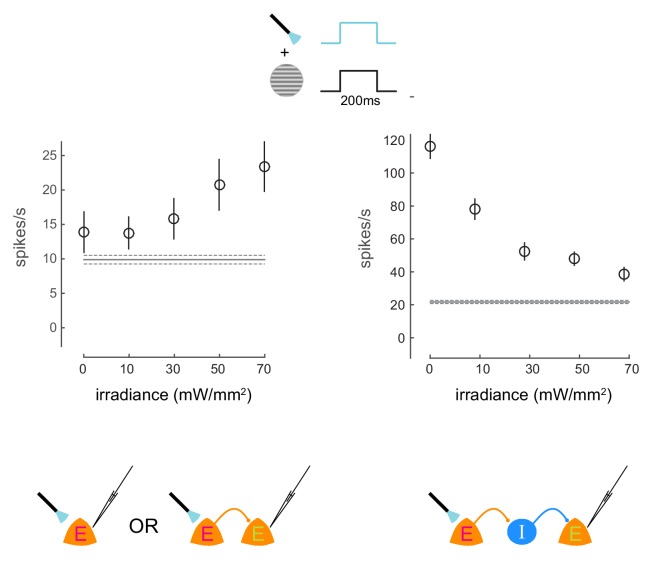
Irradiance response curves.Response of two neurons to presentations of a visual stimulus and simultaneous optical stimulation. The visual stimulus was a 20% contrast Gabor stimulus presented for 200ms. The optical stimulation consisted of a concurrent light pulse of various irradiance values (x-axis). The first unit exhibits increase in firing rate with increasing intensity of optical stimulation. The second unit exhibits decrease in firing rate with increasing intensity of optical stimulation, due to indirect network effects. Schematics at the bottom illustrate possible network scenarios. E=excitatory neuron (magenta E = opsin expressing; green E = non-opsin expressing). I=inhibitory neuron. The horizontal line represents baseline firing-rate. Mean +/- s.e.m. in all plots.